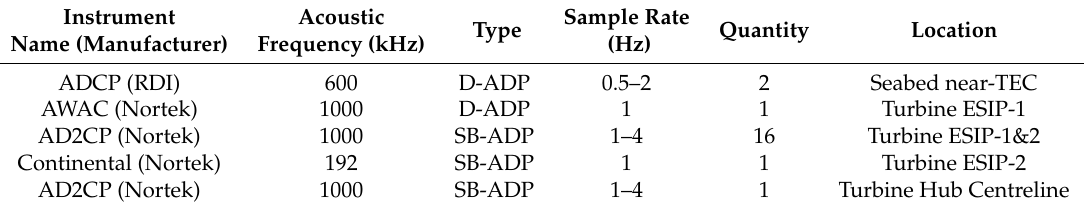
Table 2. Acoustic instrument summary